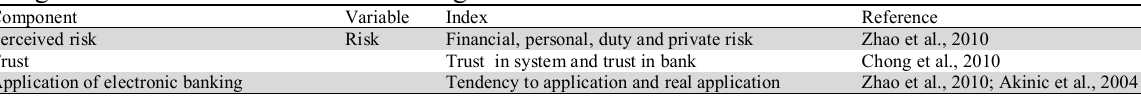
Indigenous constructs and their measuring indices